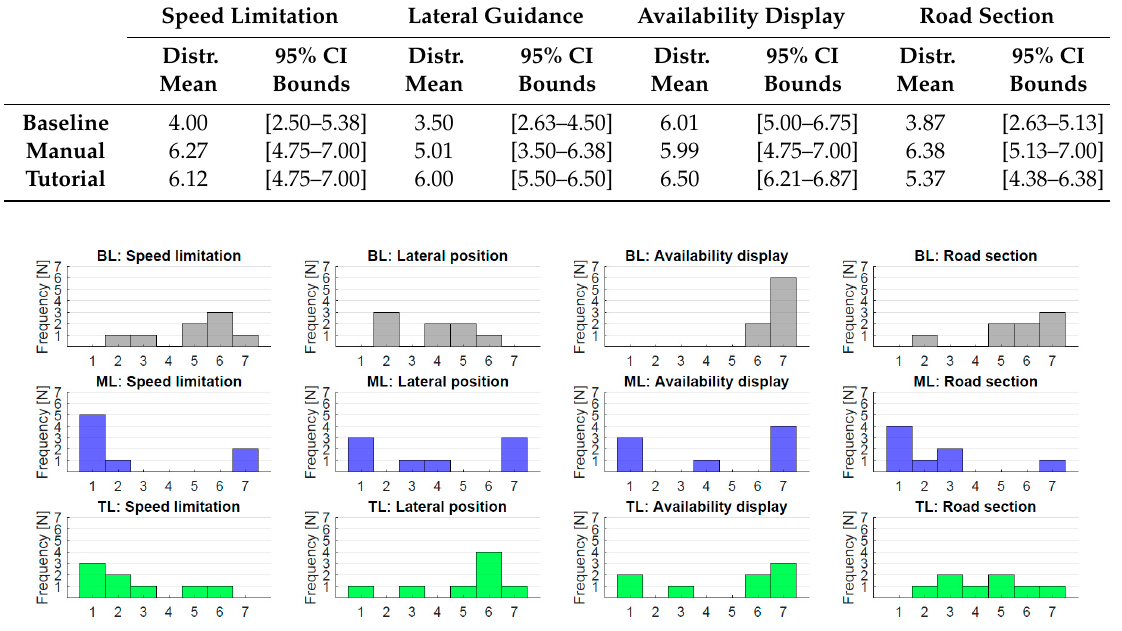
Figure 5. Frequency [n] of L2 automation mental model ratings [1–7] for the four relevant items (columns) by experimental condition (rows 1–3: baseline grey, owner’s manual blue, tutorial green). Table 7. Means and 95% CI upper and lower bounds of bootstrapped mental model distributions for the four relevant items on L2 automation by the three experimental conditions.